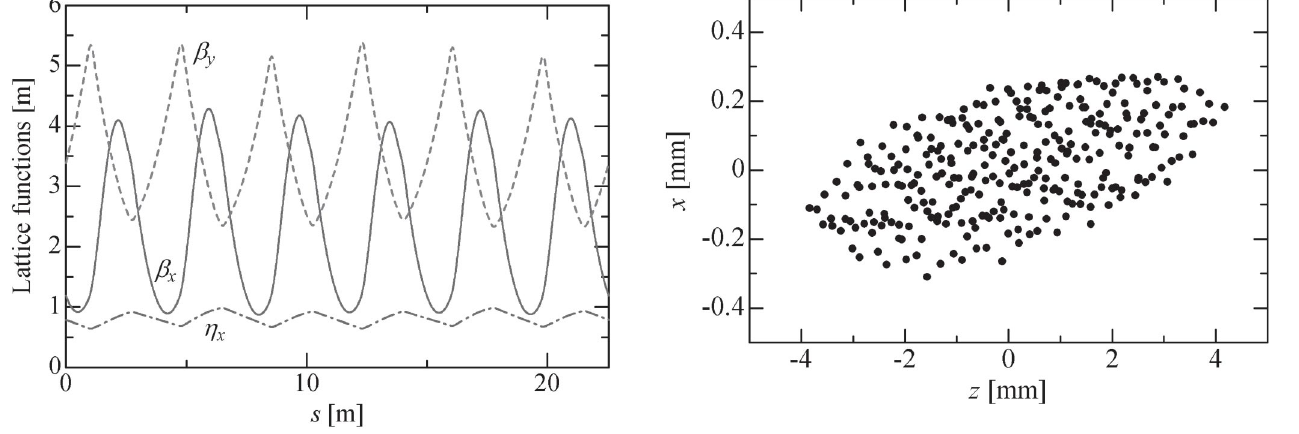
FIG. 9. Lattice functions of S-LSR with a solenoid magnet and (cid:9) are, respectively, the betatron and switched on. (cid:8) x (cid:3) y (cid:5) x dispersion functions in the absence of space charge.